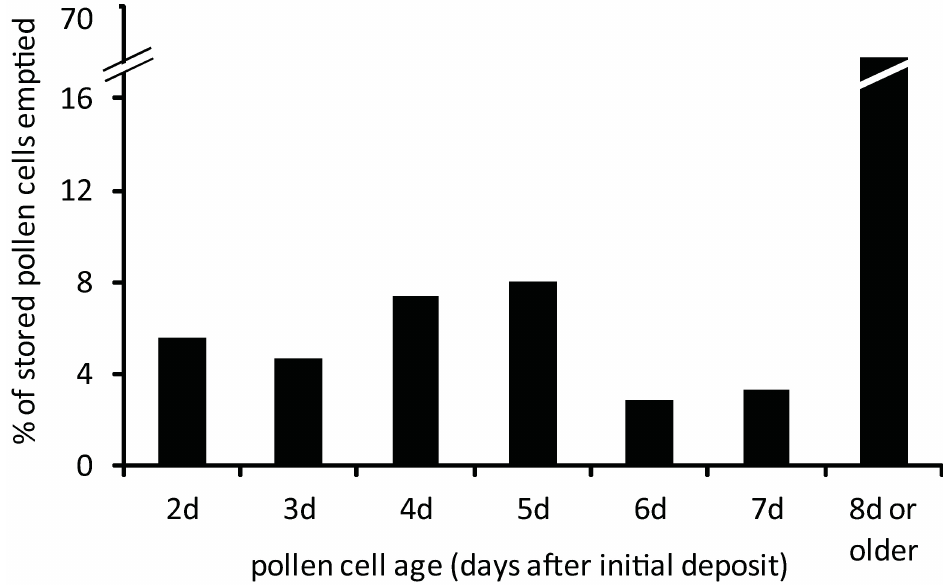
Fig 2. Proportions of different-aged pollen cells emptied during the last observation interval. Stored pollencell “age” refers to the earliest time of pollendepositionin the cell and therefore representsa maximum time since pollendeposition.The emptyingof stored pollencells formed in the last 24h interval (1d-oldstored pollencells) was undetectable and not includedin the analysis. In total, 774 stored pollencells were emptied in the last